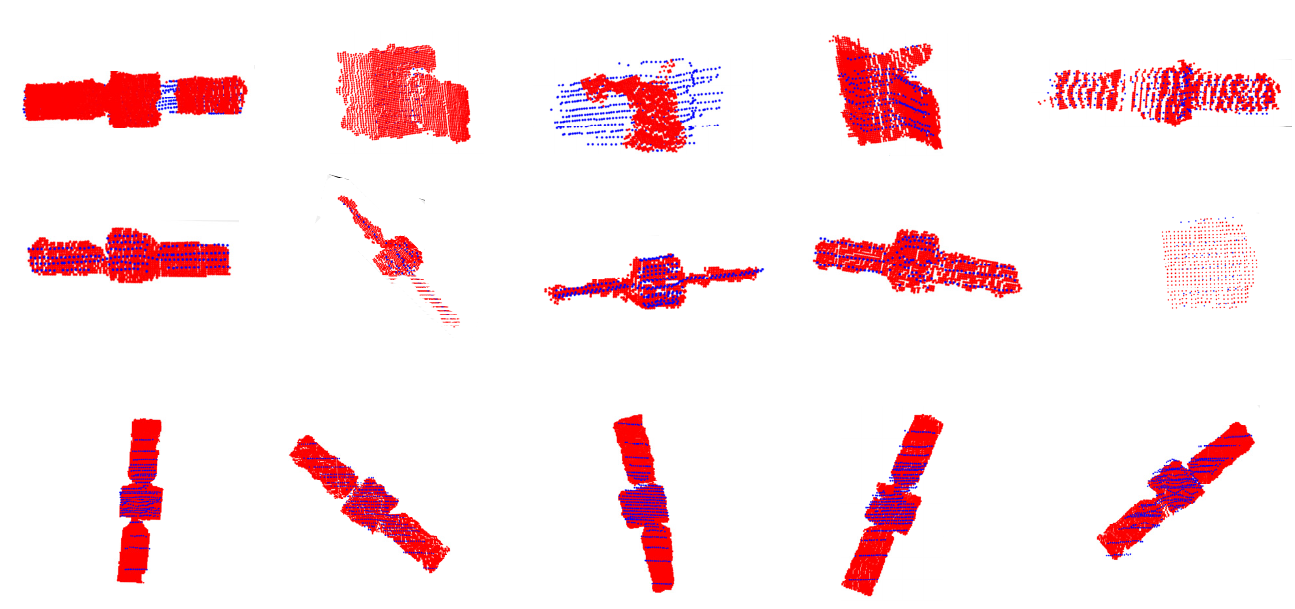
Figure 11. Results of point cloud fusion at different poses.